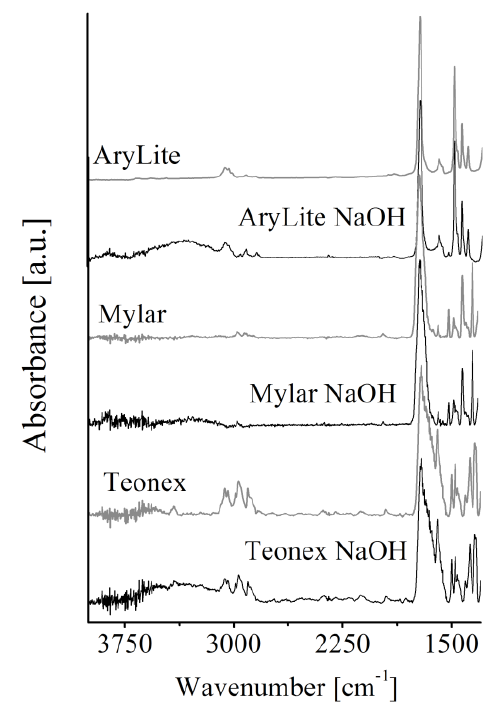
Figure 5. FTIR–ATR spectra of treated and untreated polyester films in the range 4000–1300cm -1 .